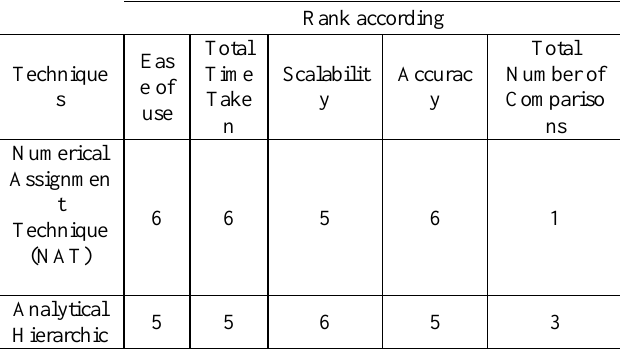
Table 2. Manual analysis of PGBLSs requirements with Game Theory